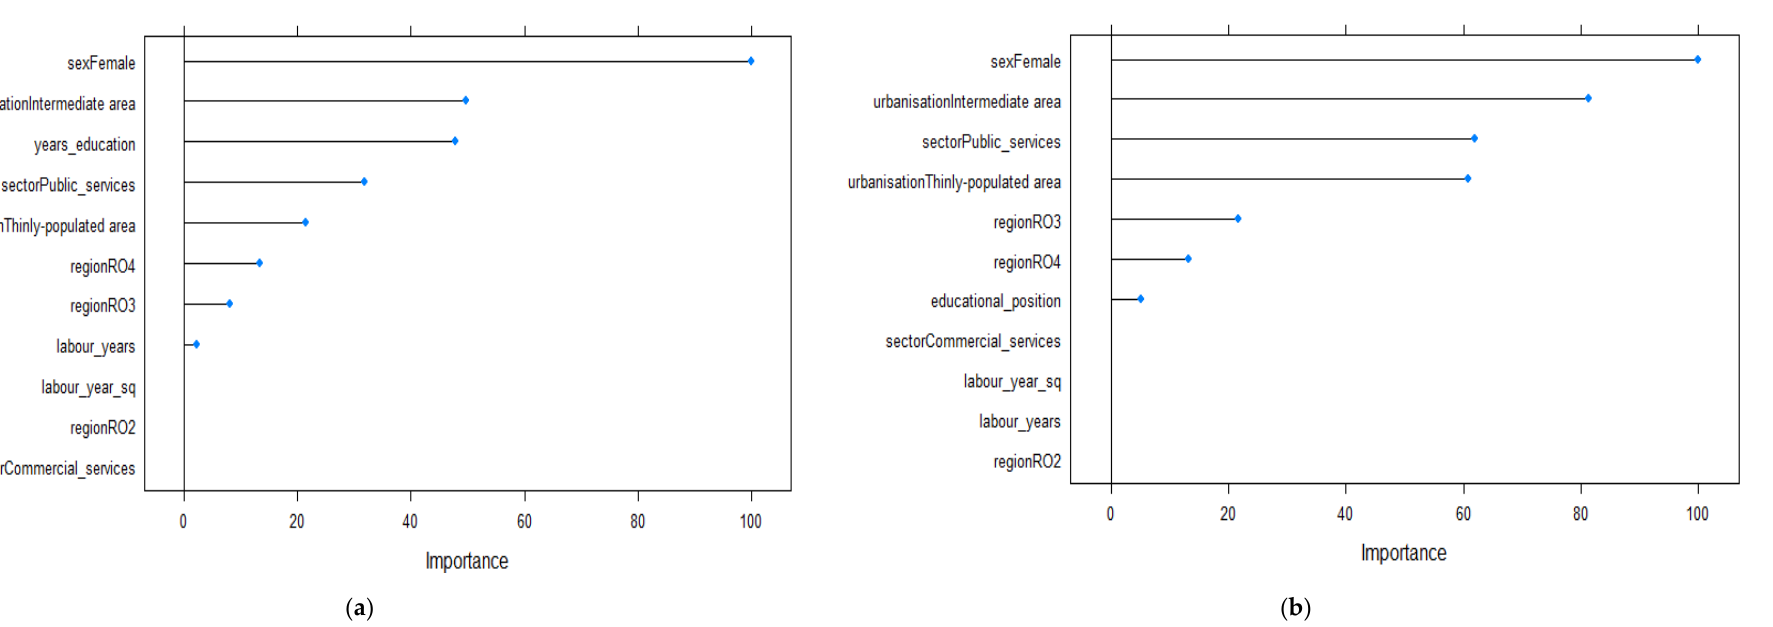
Figure 3. Relevant variables in explaining the variations in wages based on the Enet method for the 25 – 34 year old age group ( n = 947): ( a ) model 1 using the absolute measure of education; ( b ) model 2 using the relative measure of education.